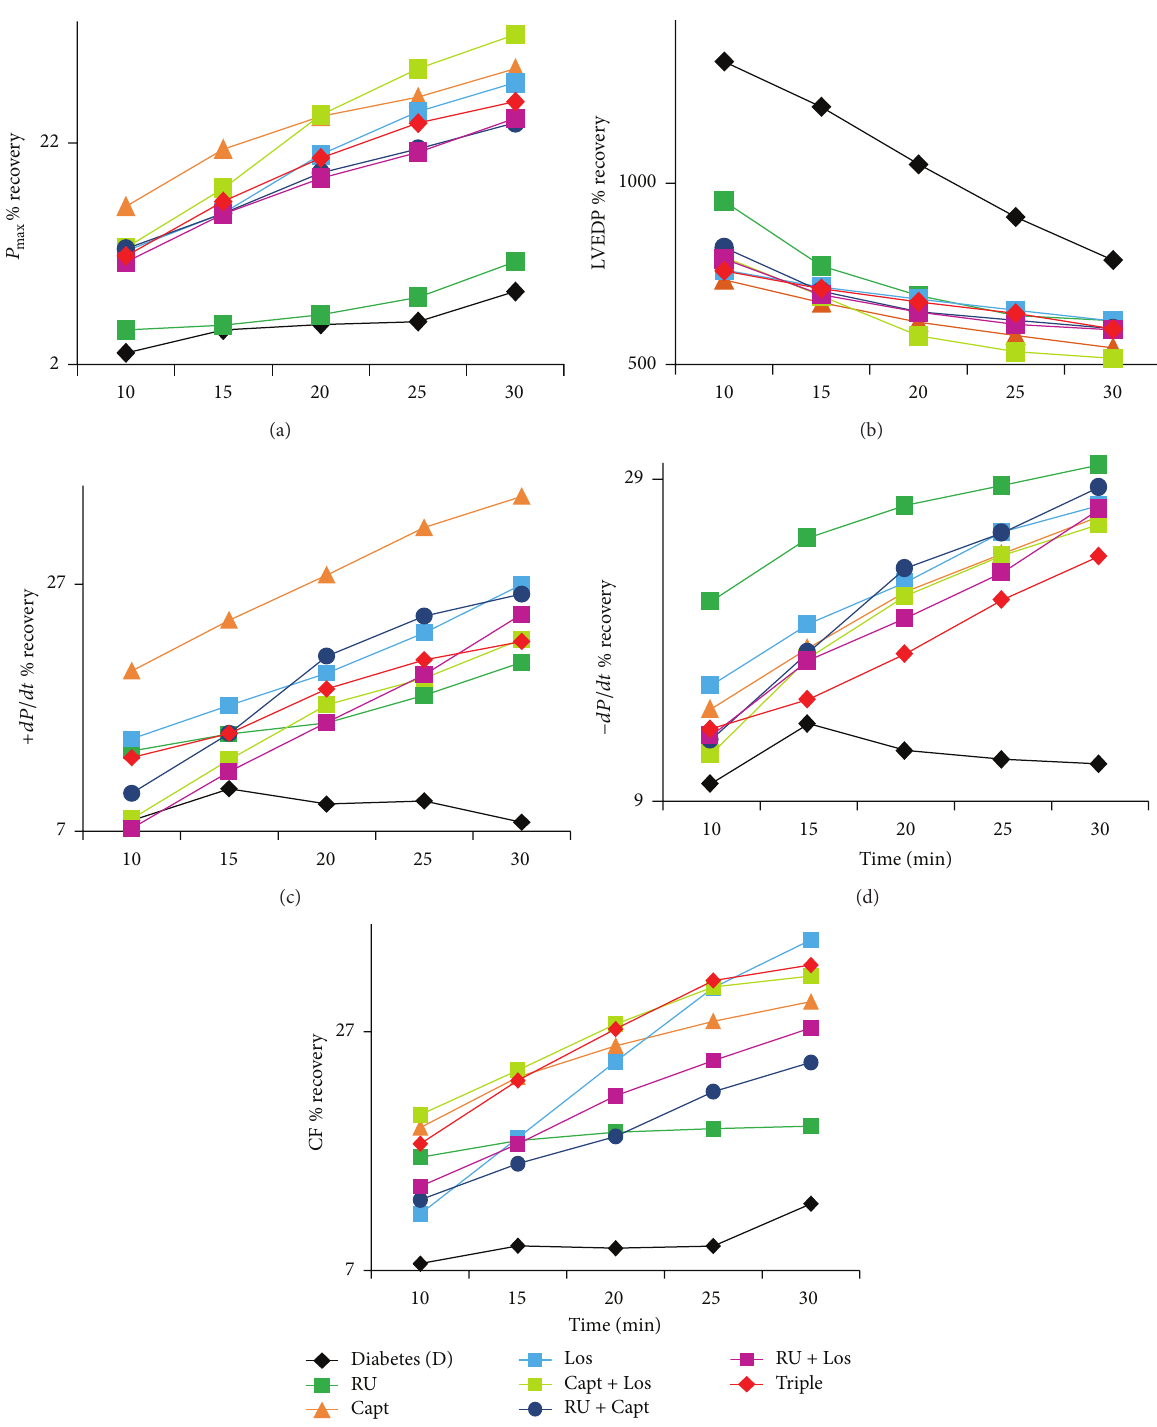
Figure 4: The effect of drugs given after ischemia on % recovery in cardiac function versus reperfusion time for (a) 𝑃 max , (b) LVEDP, (c) +𝑑𝑃/𝑑𝑡 , (d) −𝑑𝑃/𝑑𝑡 , and (e) CF in diabetic hearts. RU: RU28318; Capt: Captopril; Los: Losartan; Triple: RU28318 + Captopril + Losartan; 𝑃 max : left ventricular developed pressure; LVEDP: left ventricular end-diastolic pressure; negative derivative of pressure; CF: coronary flow; % 𝑅 : % recovery: (reperfusion/baseline) ×